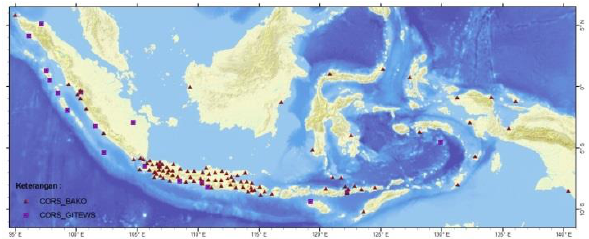
Figure 5. CORS Station Network (courtesy of BIG)